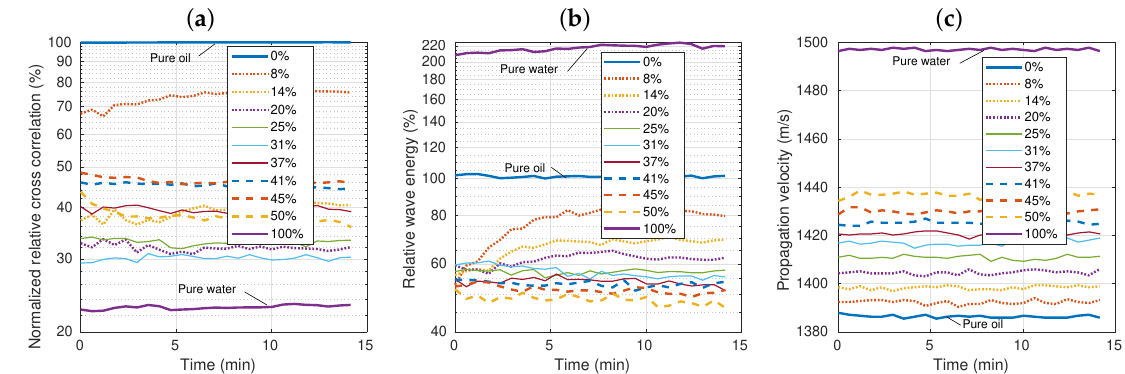
Figure 4. Experimental results of the short-term test: the relative cross-correlation ( a ), relative wave energy ( b ), and propa- gation velocity ( c ) as a function of time at 22 ± 0.2 ◦ C.